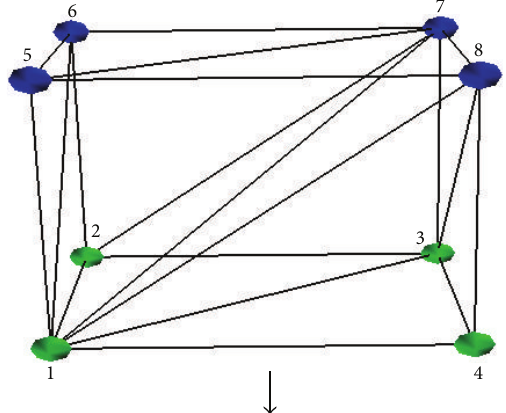
Figure 2: A 10 × 10 × 10 m cube mesh with eight nodes and six tetrahedra is constrained at the blue nodes and pulled downwards from the green nodes.